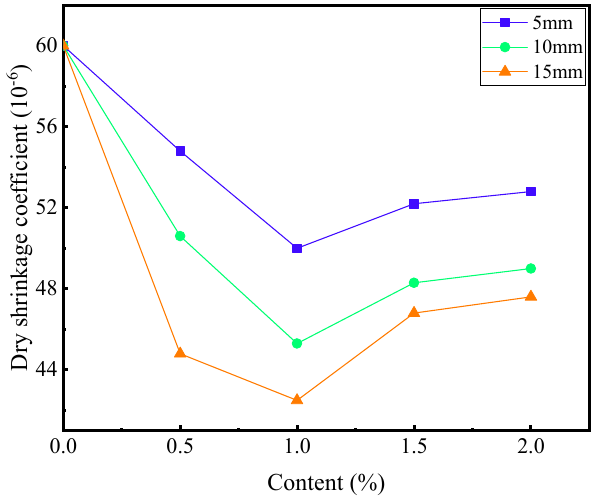
Figure 7. 28-day dry shrinkage coefficient test results.